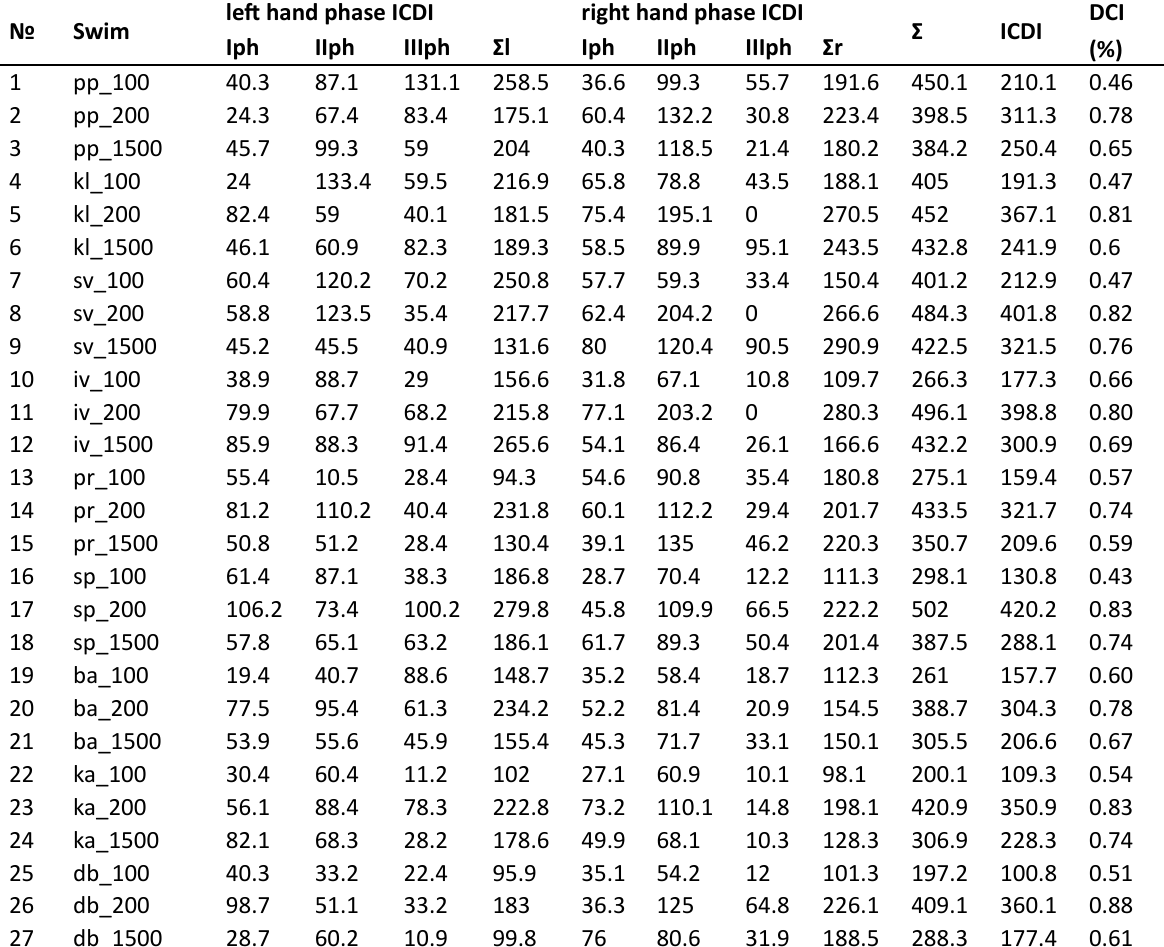
Table 1. I ntegral characteristics of the swimming cycle of crawl-stroke swimmers participated in the research left hand phase ICDI right hand phase ICDI № Swim